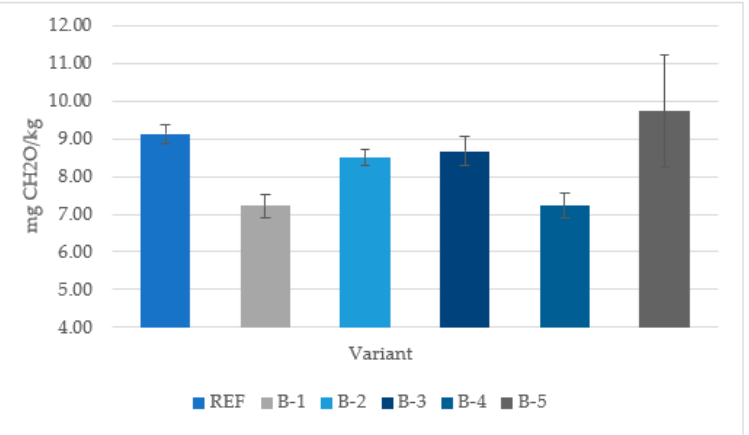
Figure 4. Formaldehyde emission in three-layer plywood panels produced with UF resin.